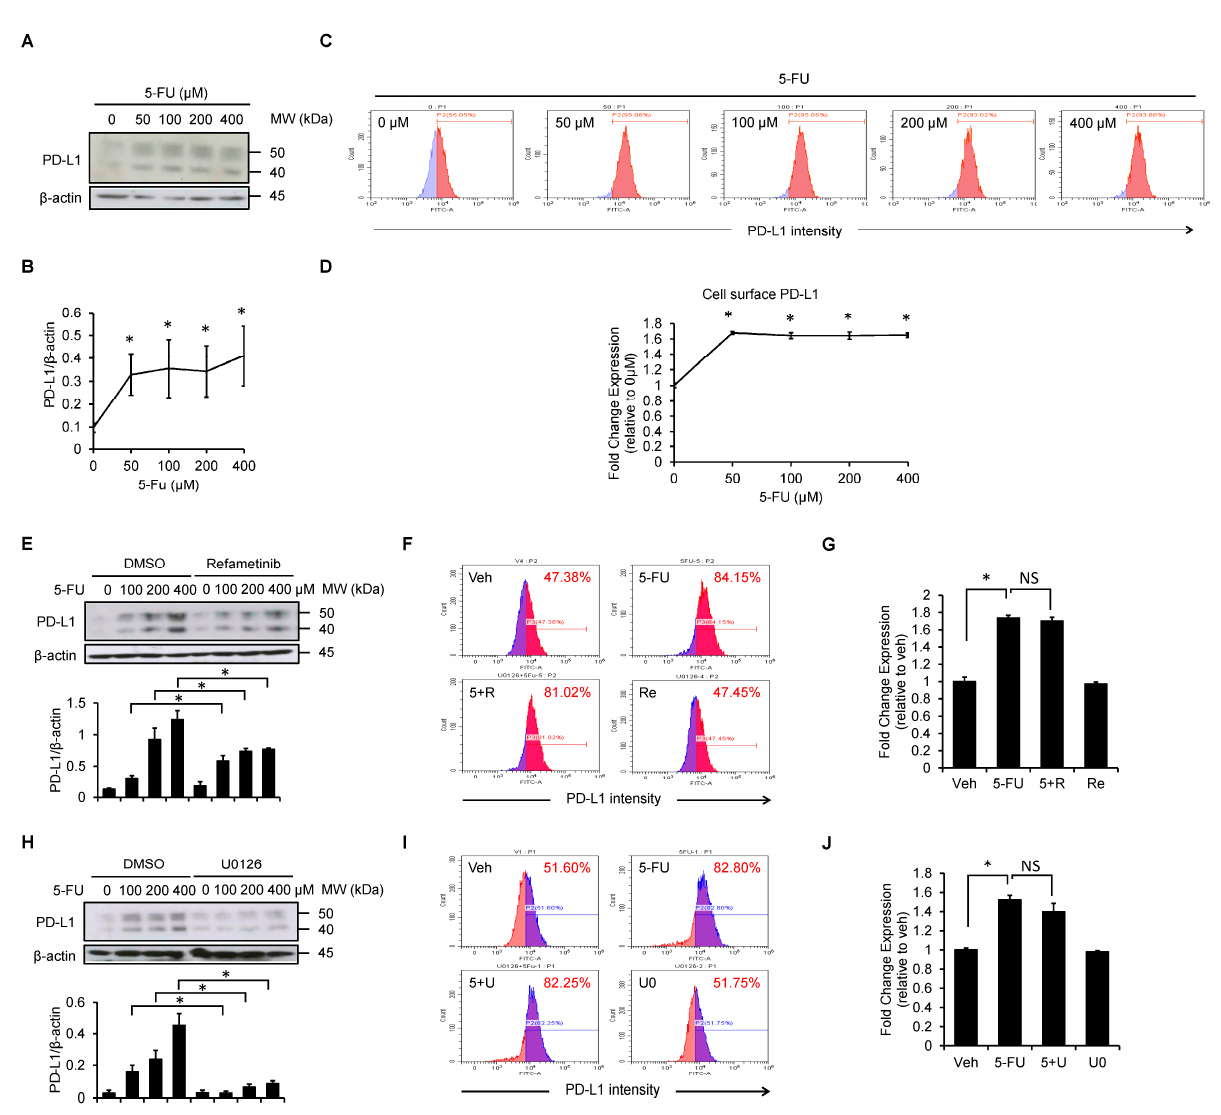
Figure 3. Refametinib mitigates 5-FU-induced PD-L1 expression in SCC4 cells. ( A – D ) The cells were treated with increasing concentrations of 5-FU (50, 100, 200, and 400 µM) for 24 h. The ( A ) Western blot analysis and ( B ) relative densitometric graph showing the total level of PD-L1 expression. The ( C ) flow cytometry graph and ( D ) relative fluorescence intensity showing the surface expression of PD-L1. ( E – J ) The cells were pre-incubated with ( E – G ) Refametinib (Re; 50 nM) or ( H – J ) U0126 (U0 or U; 50 nM) for 1 h and then treated with increasing concentrations of 5-FU (100, 200, and 400 µ M) for 24 h. The ( E , H ) Western blot analyses showing the total level of PD-L1 expression. The ( F , I ) flow cytometry graph and ( G , J ) relative fluorescence intensity showing the surface expression of PD-L1. * p < 0.05, as compared to the control or as compared between the two indicated groups. NS: not significant; Veh: vehicle; 5 + R: 5-FU + Refametinib; 5 + U: 5-FU + U0126; Re: Refametinib; U0 or U: U0126. All experiments were independently performed at least three